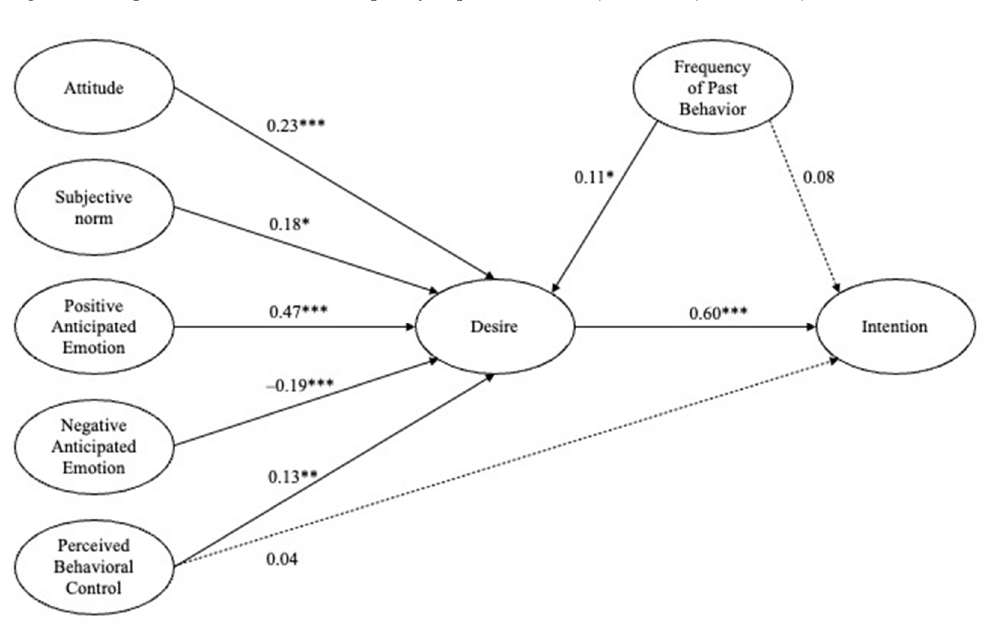
Figure 2. The research model with path coefficients. * p < 0.05; ** p < 0.01; *** p < 0.001